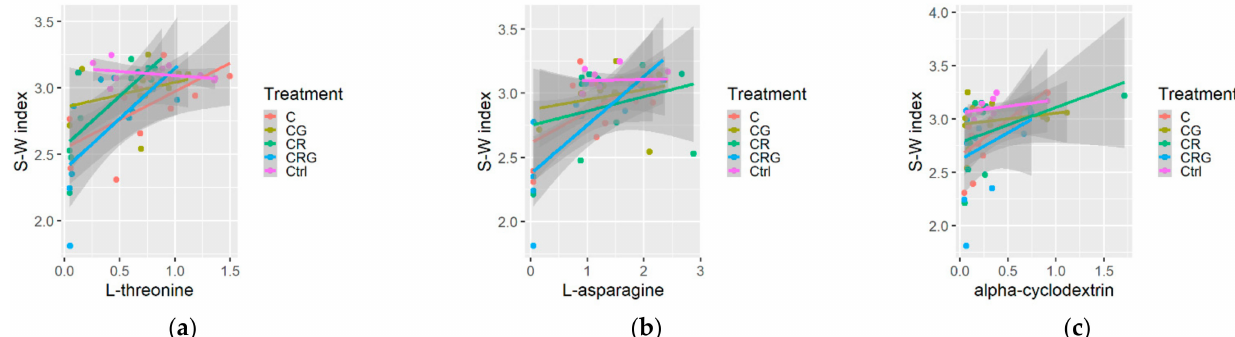
Figure 6. Shannon–Wiener diversity index values within treatments as a function of carbon sources: ( a ) L-threonine, ( b ) L-asparagine and ( c ) α -cyclodextrin from the group of substrates ( a ) differing among the treatments, ( b ) high-activity substrates among all the treatments and ( c ) low-activity substrates among all the